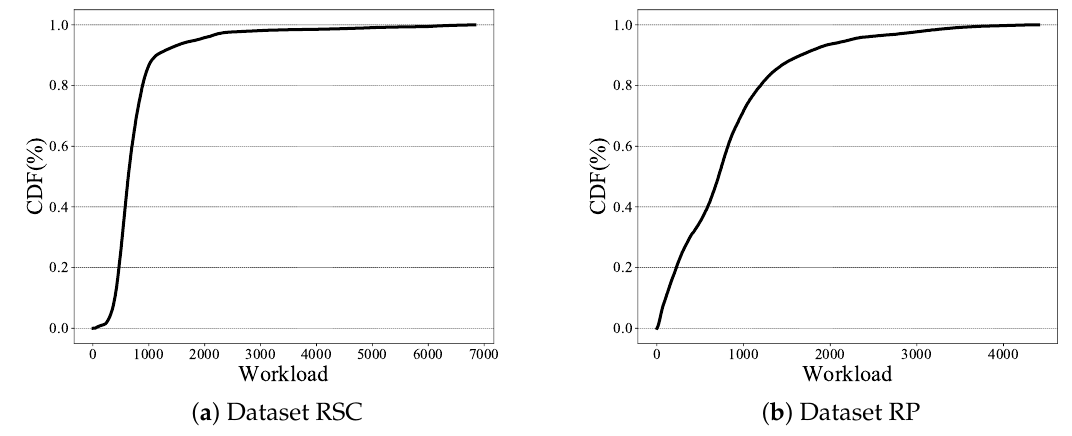
Figure 6. The CDF of the workload.